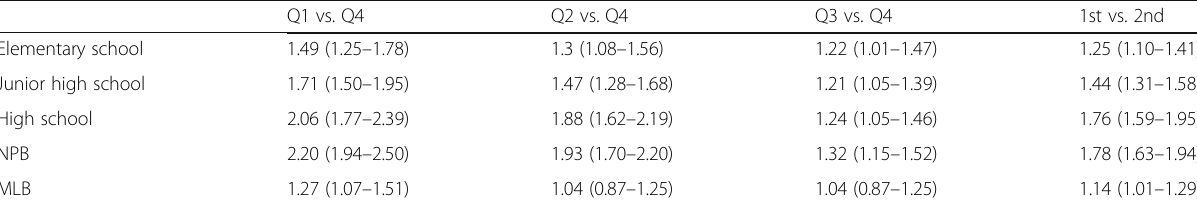
Table 2 Odds ratio and 95% confidence interval for each group Q1 vs. Q4